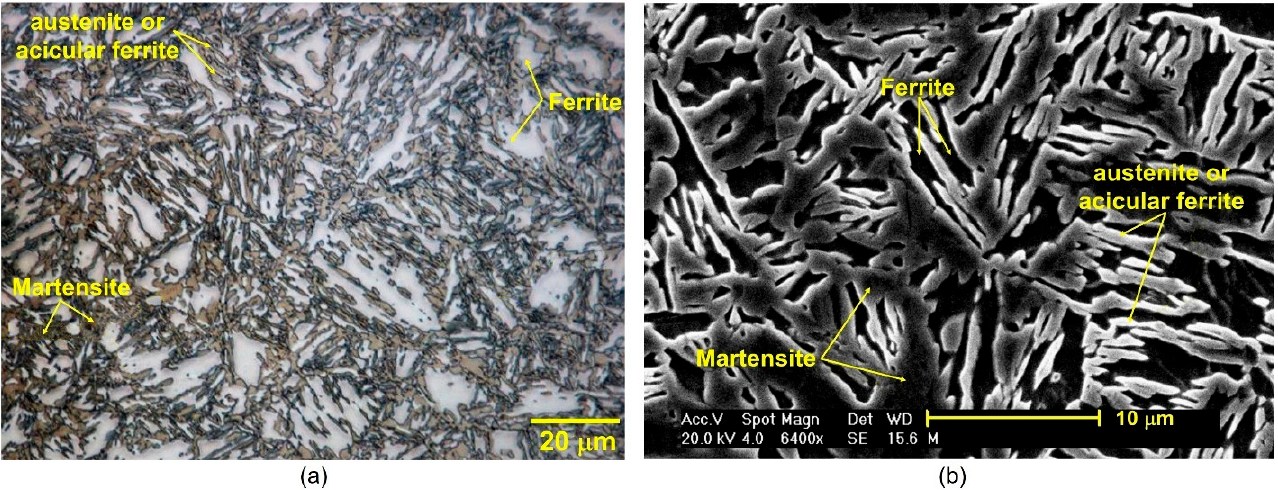
Figure 3. Microstructure obtained during intercritical annealing treatment at 1023 K (750 °C) for 420 s, etched with nital 3% ( a ) Optical microscopy and ( b ) Electron microscopy.